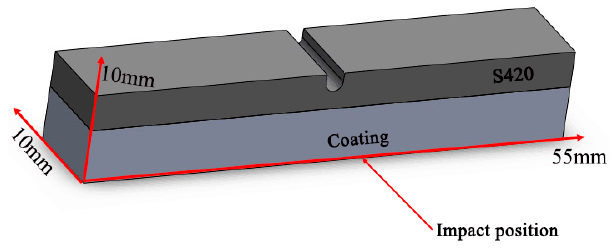
Figure 2. Schematic diagram of impact specimens.